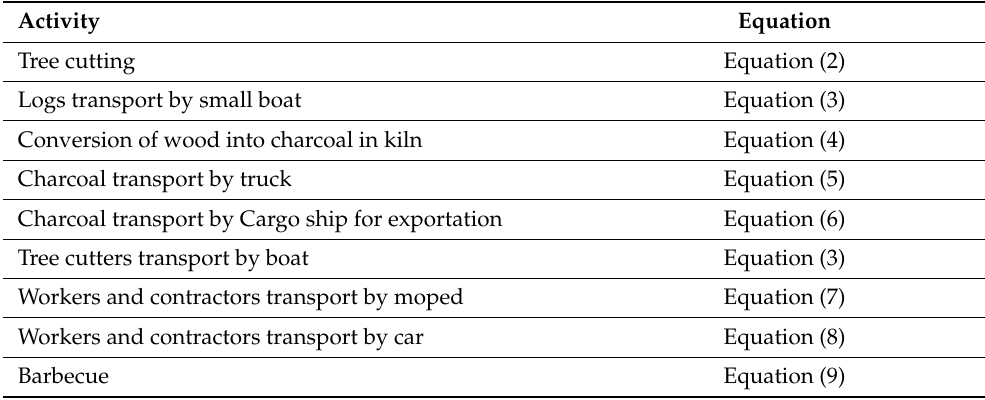
Table 1. Equations used for the calculation of carbon emissions for each activity in the pole and charcoal production chain. The emission factors were computed using Equation